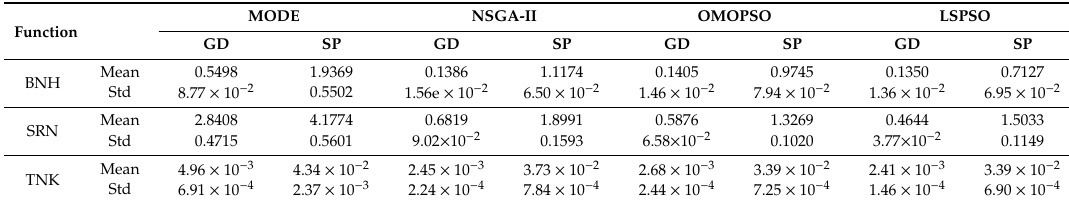
Table 3. The GD and SP obtained by MODE, NSGA-II, OMOPSO and LSPSO in solving BNH, SRN and